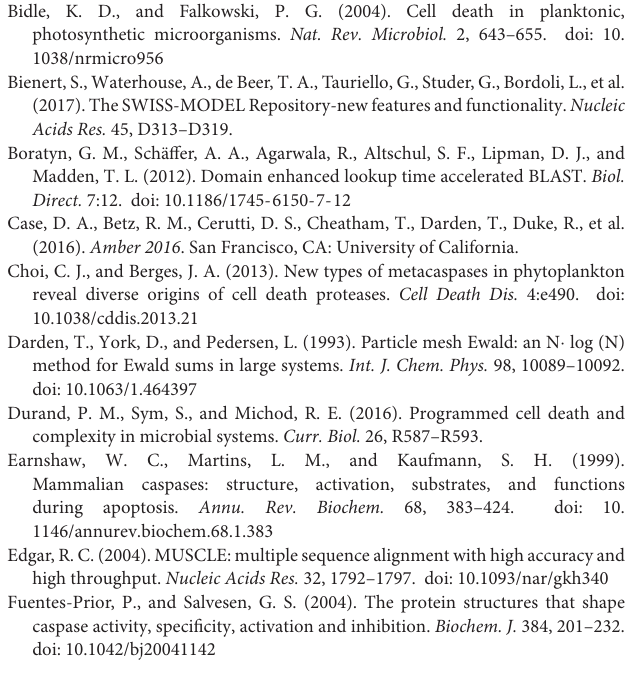
Supplementary Figure 1 | Neighbor-joining tree defining phylogenetic relationship within distinct (A) HC I, (B) HC II and (C) HC III clades. Supplementary Figure 2 | Neighbor-joining tree defining phylogenetic relationship within distinct HC IV clades. Supplementary Figure 3 | Neighbor-joining tree defining phylogenetic relationship within distinct (A) HC V, (B) HC VI, (C) HC VII, (D) HC VIII and (E) HC IX clades. Supplementary Figure 4 | Neighbor-joining tree defining phylogenetic relationship within distinct (A) YS and (B) YN clades. Supplementary Table 1 | Domain positioning and configuration of all the putative cyanobacterial orthocaspases. Supplementary Table 2 | Detail of templates used for model refinement and energy minimization for three homology models of putative orthocaspases of Nostoc sp. PCC